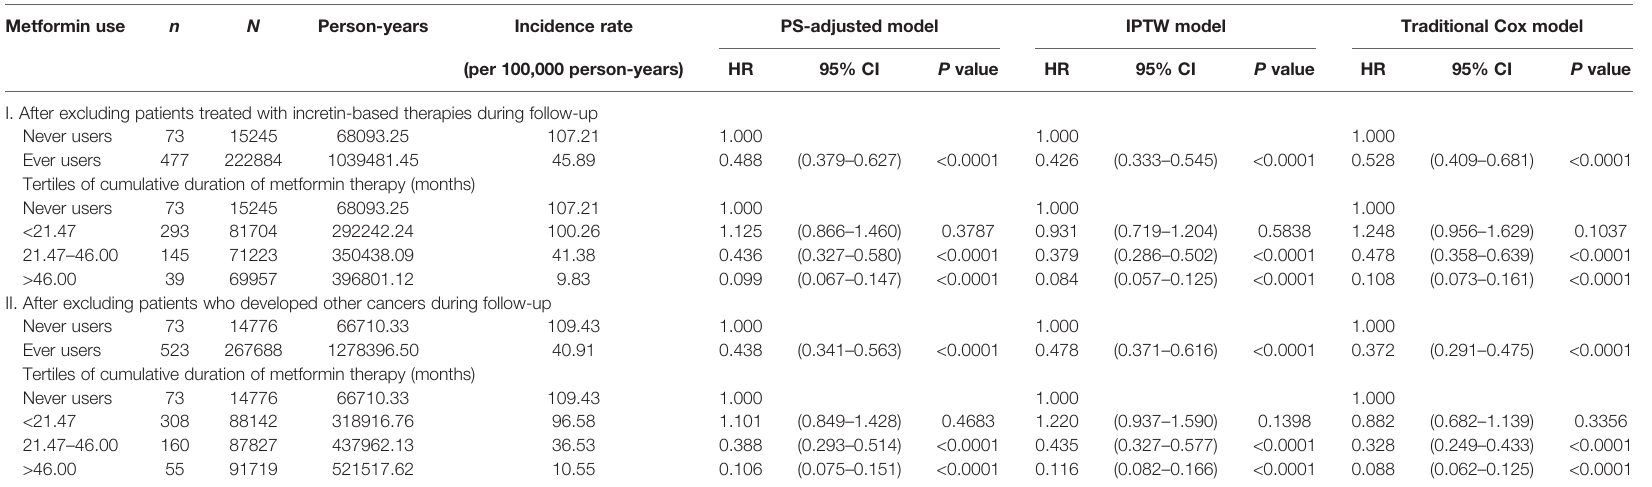
TABLE 3 | Sensitivity analyses in the unmatched